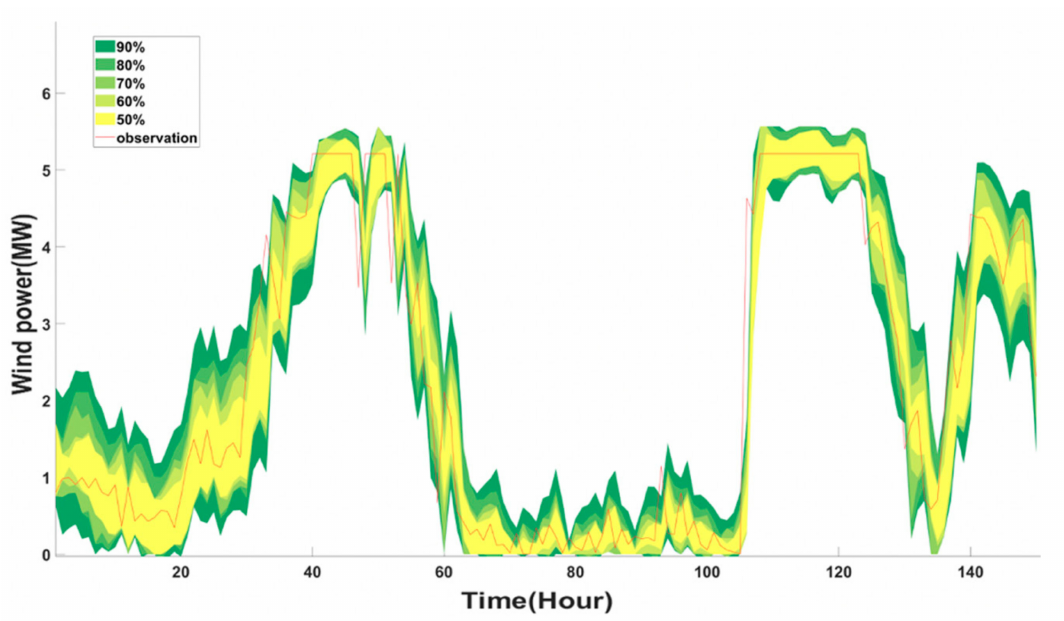
Figure 14. Three-h-ahead probabilistic forecasting results by Method 1b (WRFD,